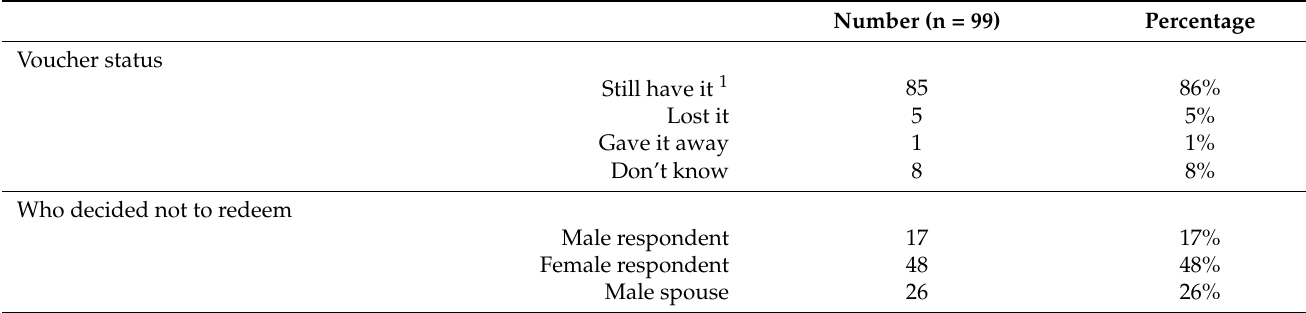
Table 3. Households that did not redeem